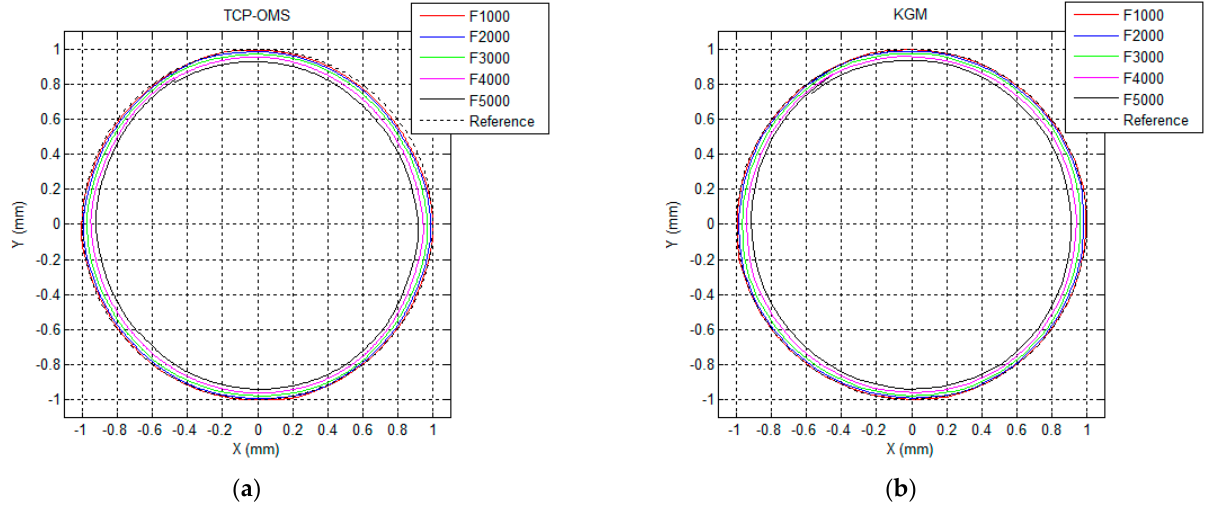
Figure 19. TCP contour measurement perform circular tests with each feed rate. ( a ) Circular tests adopt TCP − OMS; ( b ) circular tests adopt KGM.